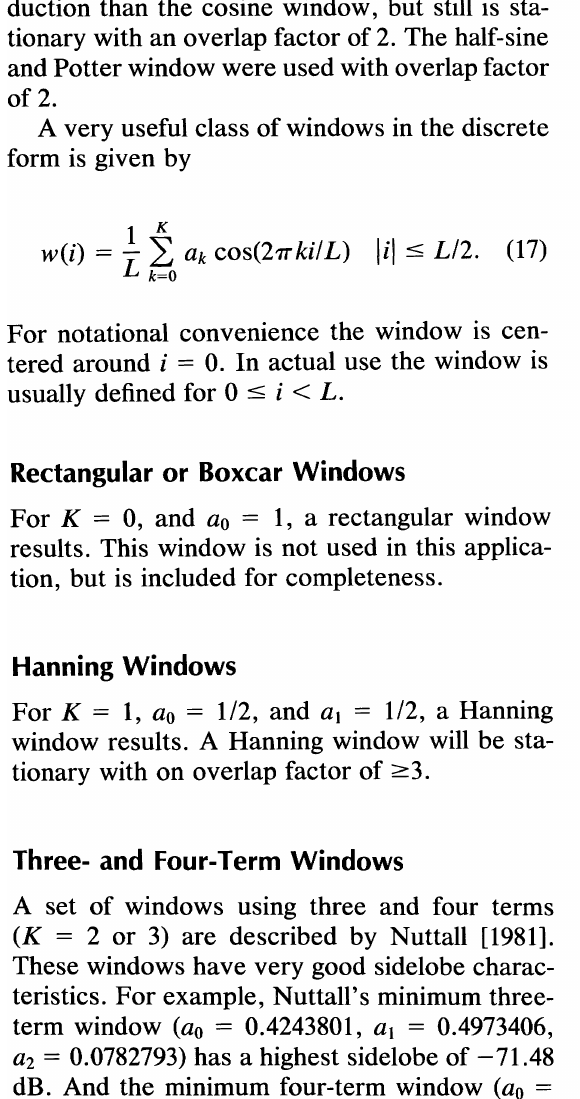
Table 1. Summary of